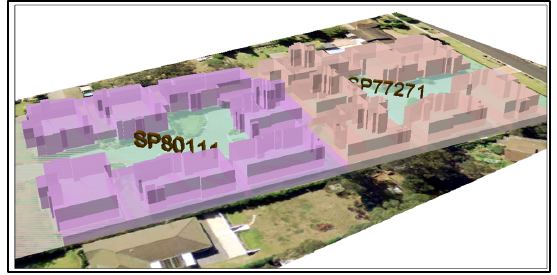
Figure 7: A staged strata development on a flat image